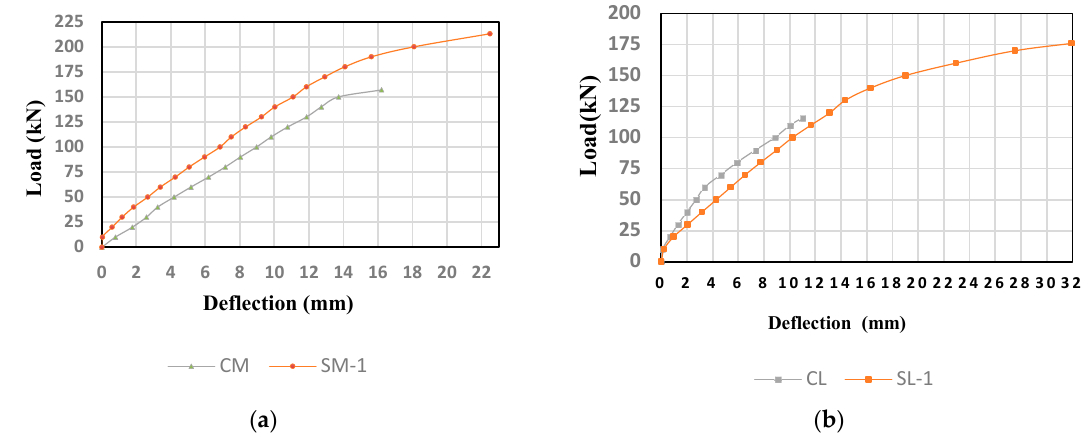
Figure 10. Load–deflection curve for: ( a ) CM and SM-1, ( b ) CL and SL-1.